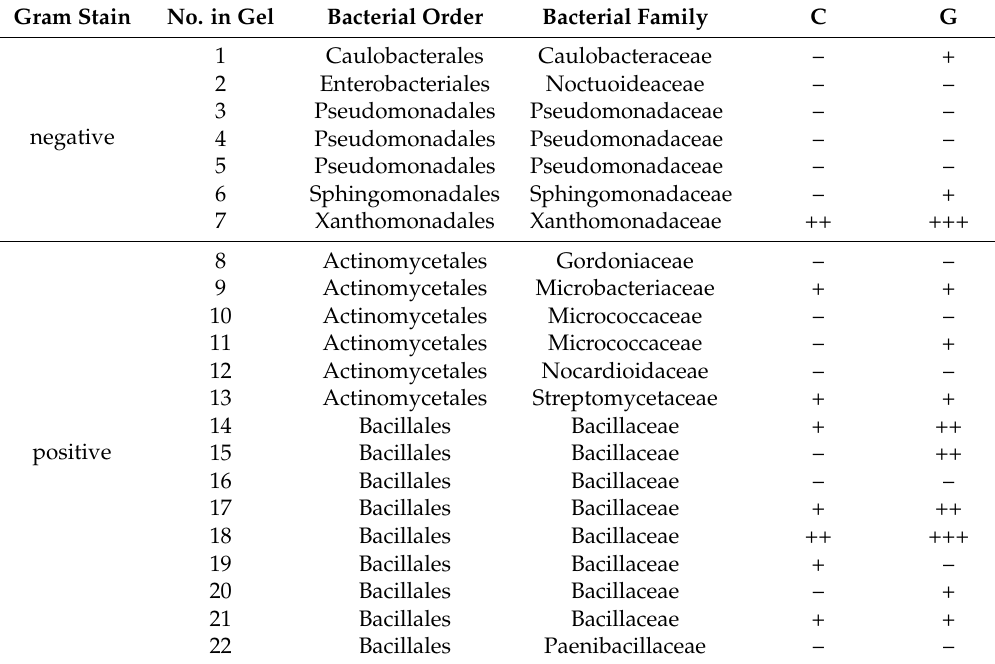
Table 2. Identified bacterial strains from freshly collected birch pollen .